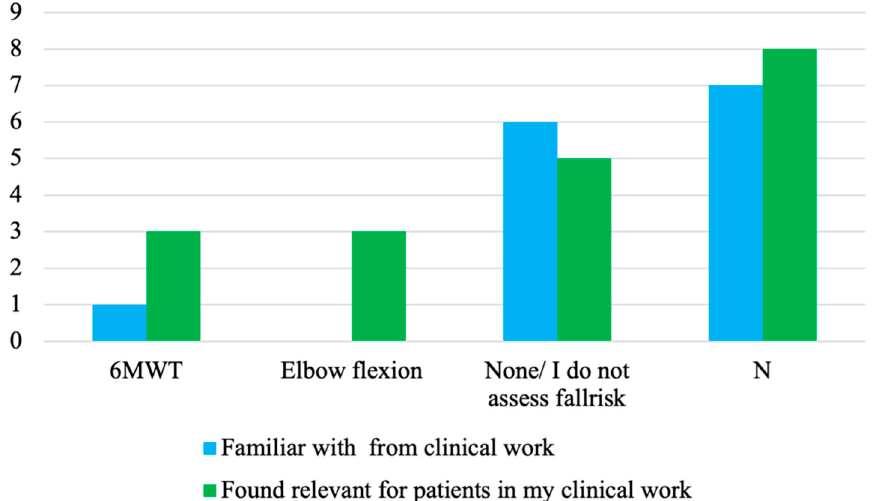
Figure 5. The participants’ familiarity with, and perceived relevance of, the two FRA methods used in the SFRA studies with patients that were not selected in sub-study 3.